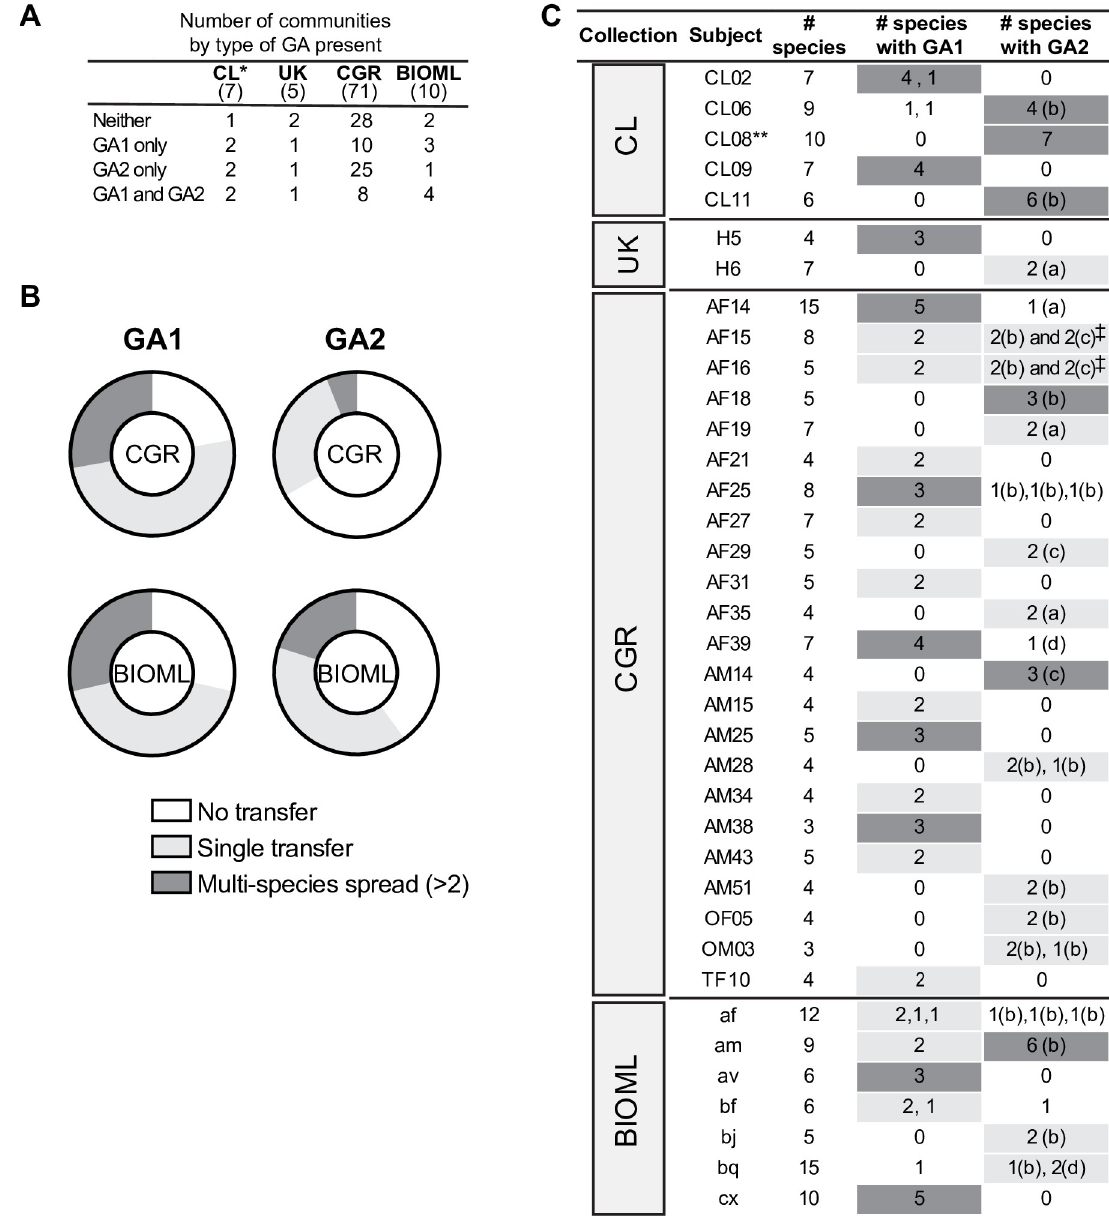
PLOS Genetics | https://doi.org/10.1371/journal.pgen.1009541 April 26,